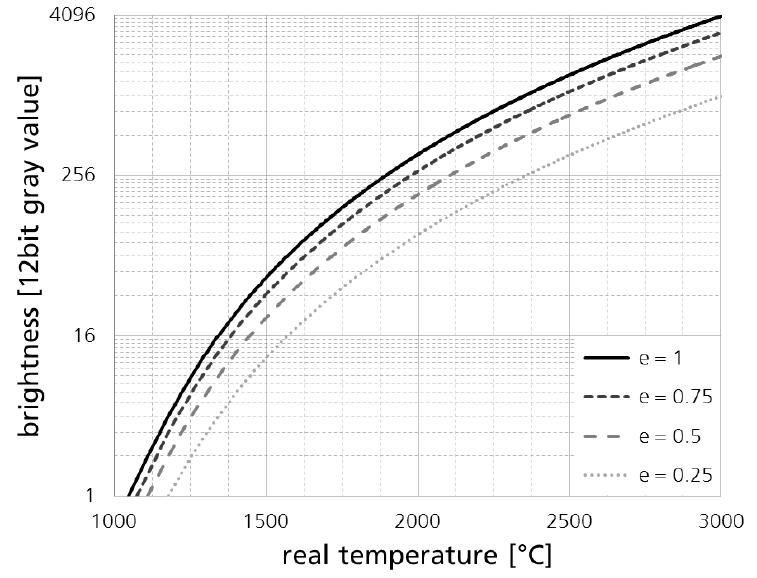
Figure 3. Temperature–gray value–calibration curves for different emission coefficients.